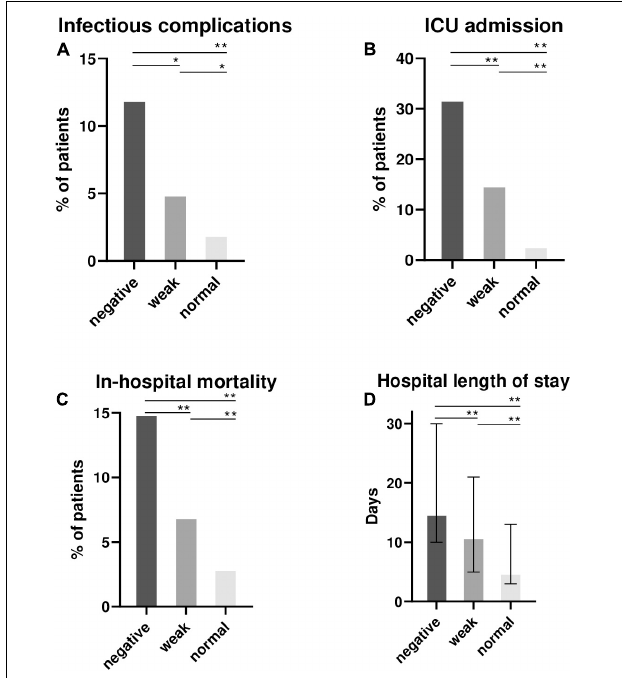
FIGURE 2 | Clinical outcomes of 872 hospitalized patients according to the mitogen response of QFT (negative, weak or normal). Proportion of patients with infectious complications during hospital stay after QFT sampling (A) , intensive care unit (ICU) admissions (B) , in-hospital mortality (C) and the median (interquartile range) hospital length of stay (D) were recorded and represented according to the mitogen response: negative (IFN- γ ≤ 0.5 IU/ml), weak (IFN- γ = 0.5–2 IU/ml) and “normal” (IFN- γ > 2 IU/ml). NB: QFT, QuantiFERON-TB Gold; ICU, intensive care unit; IFN- γ , interferon γ . Comparisons were made between the 3 groups using Kruskall-Wallis test for continuous variable, and the Chi-square test for qualitative variables. Post-hoc 2 × 2 comparisons were performed using the Wilcoxon Mann-Whitney test and Chi-square test as appropriate. False Discovery Rate post hoc correction for multiple comparisons was used and P value reported in the figure : * P < 0.05; ** P <